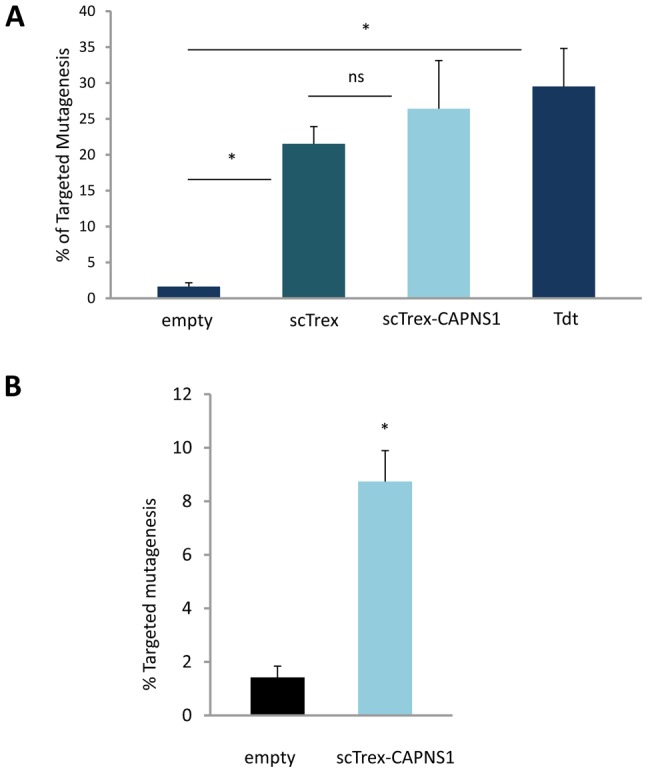
Targeted mutagenesis in primary cells and iPS.Cells were transfected with the CAPNS1m meganuclease in the absence (empty) or presence of DNA-end processing enzymes; scTrex, single-chain Trex2; scTrex-CAPNS1, meganuclease fused to scTrex; Tdt, terminal deoxynucleotidyltransferase. Frequency of TM as determined by sequence analysis of locus specific amplicons; ns, not significant. (A) Frequency of TM measured in Detroit 551 human fetal fibroblasts in 2 independent experiments. (B) Frequency of TM measured in iPS in 2 independent experiments.